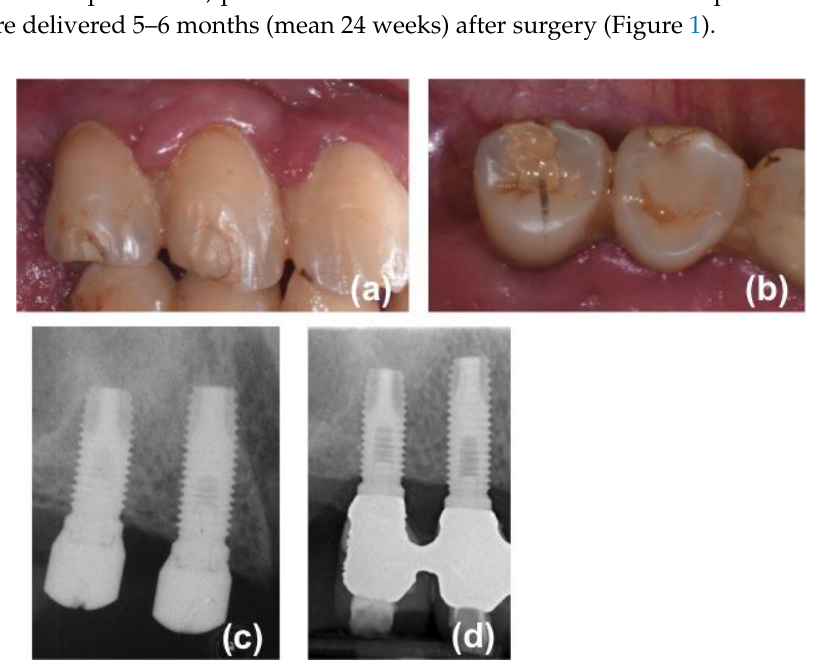
Figure 1. One of the patients included in the present research: ( a ) intraoral view of the bridge at the five-year follow-up appointment; ( b ) occlusal view of the bridge at the five-year follow-up appointment; ( c ) endoral radiograph three months after implant insertion; ( d ) endoral radiograph taken at the five-year follow-up appointment.